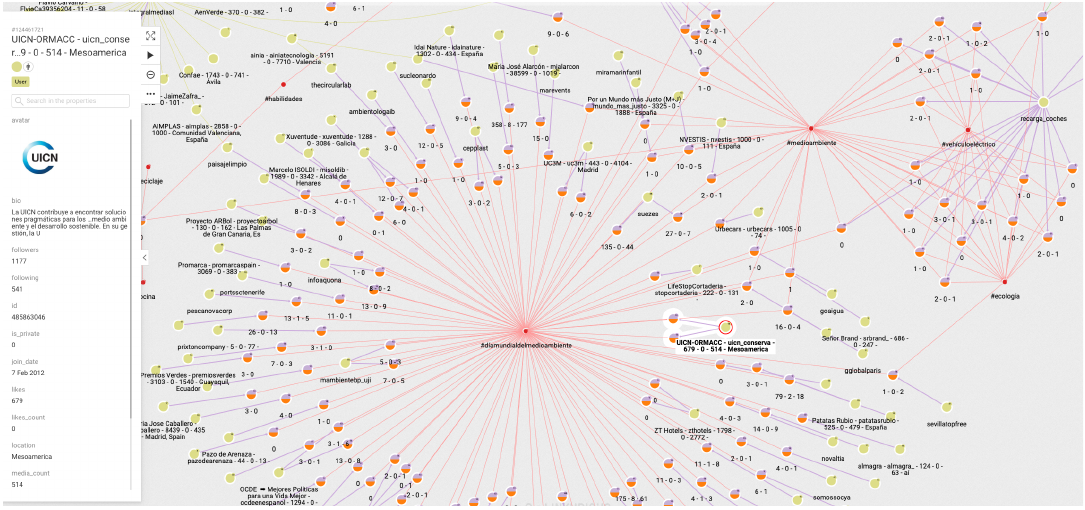
Figure 6. Global picture of a graph of tweets.